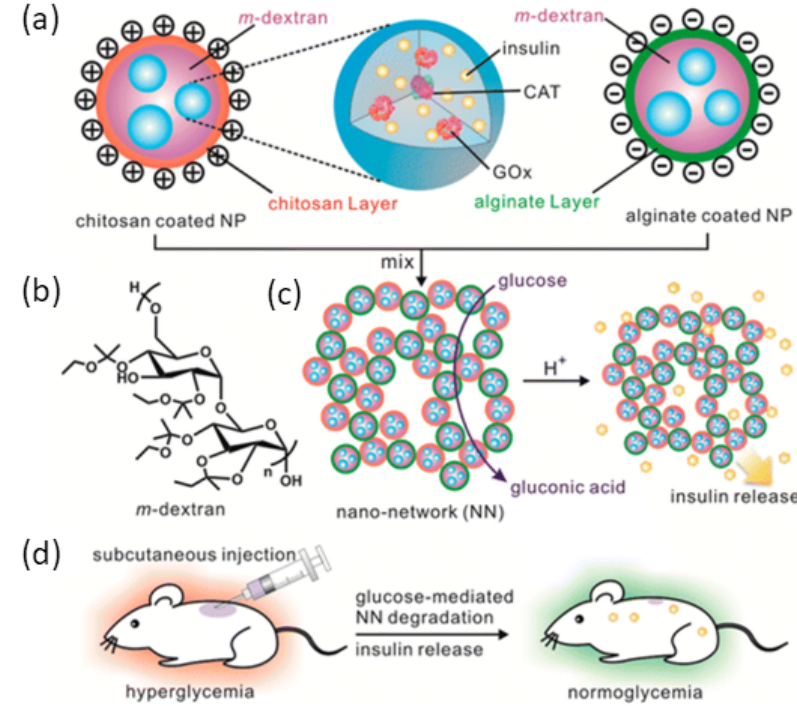
Figure 8. ( a ) Polymeric NPs functionalized with glucose-specific enzymes, CAT and GOx, and insulin. ( b ) m-dextran coated with CHC and alginate, respectively. ( c ) Depiction of the nano-network and stimulated insulin release via GOx conversion to gluconic acid. ( d ) SC insulin delivery for the treatment of DM in STZ-induced T1D mice. Adapted with permission from [66]; Published by ACS Nano,